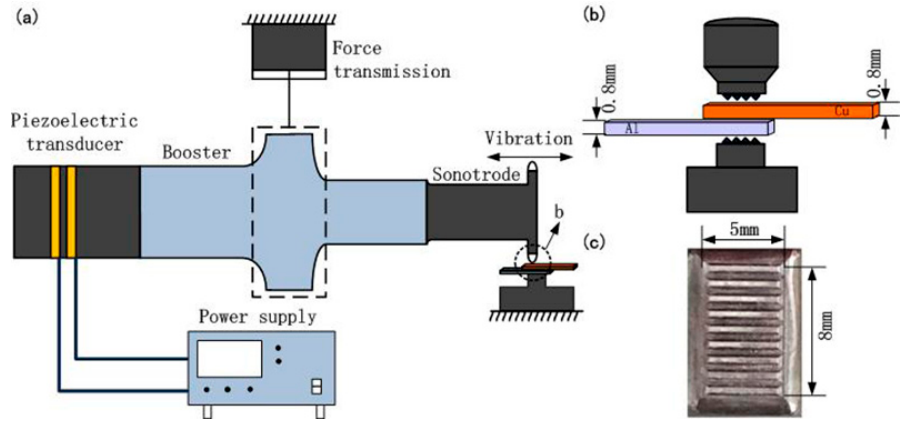
Figure 1. ( a ) A schematic diagram of the ultrasonic welding system, ( b ) partial enlargement and ( c ) knurl pattern of the sonotrode. Table 1. Detailed welding parameters.